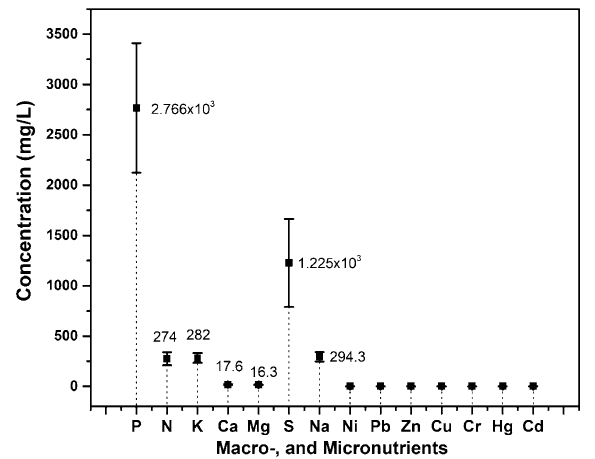
Figure 5. Macro-, and micronutrients detected from the bio-electrohydrogenesis left-over residues